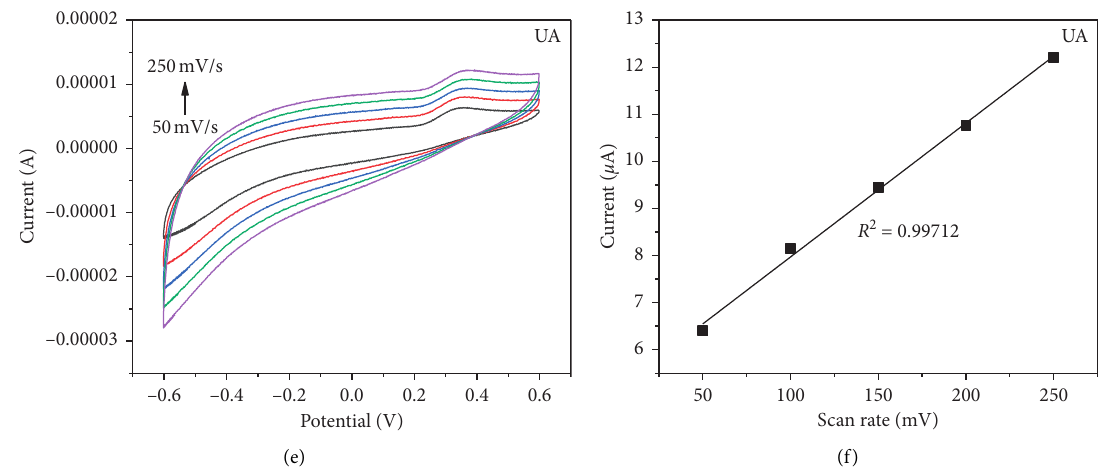
Figure 3: CV voltammograms of AA (a), DA (c), and UA (e) on PdNPs/rGO/GCE at 50, 100, 150, 200, and 250mV · s − 1 scan rates; relationship between the peak current of (b) AA, (d) DA, and (f) UA and the scan